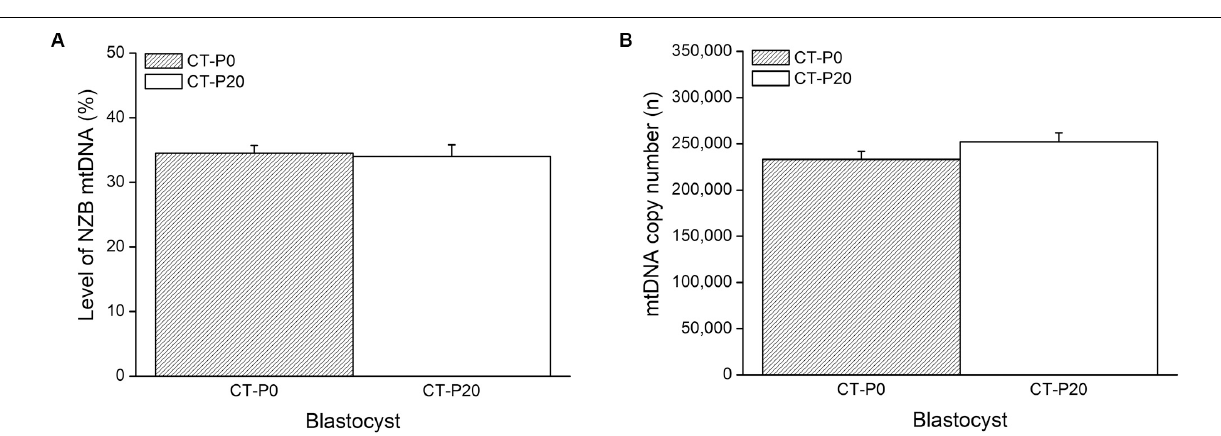
FIGURE 3 | Rapamycin treatment precludes elimination of photoirradiated mitochondria during early embryogenesis. CMXRos-loaded zygotes containing mtDNA of NZB origin were photoirradiated for either 0 (P0) or 20 (P20) s to induce mitochondrial damage. Mitochondria from these zygotes were injected by cytoplasmic transfer (CT) into B6 zygotes, resulting in CT-P0 and CT-P20 groups, respectively. CT-derived blastocysts were assessed as for the levels of NZB (A) and total (B) mtDNA. No statistical difference ( P >